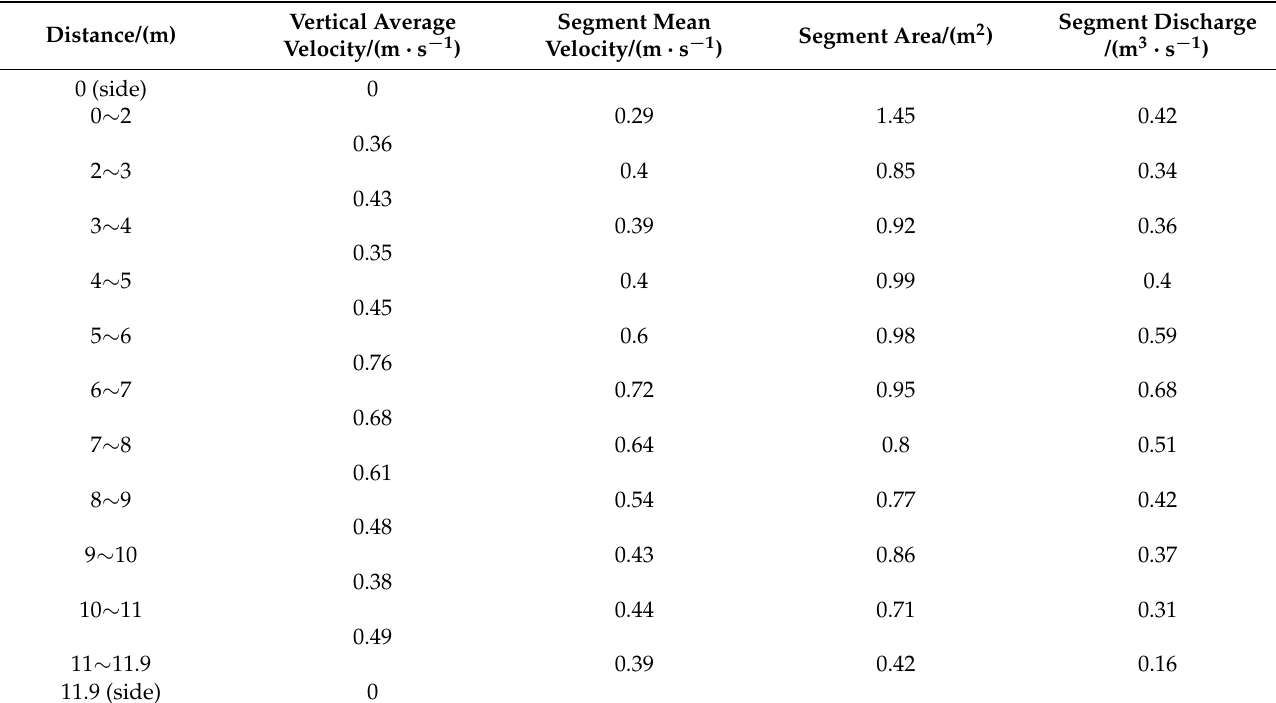
Table 1. Current meter measurement results.